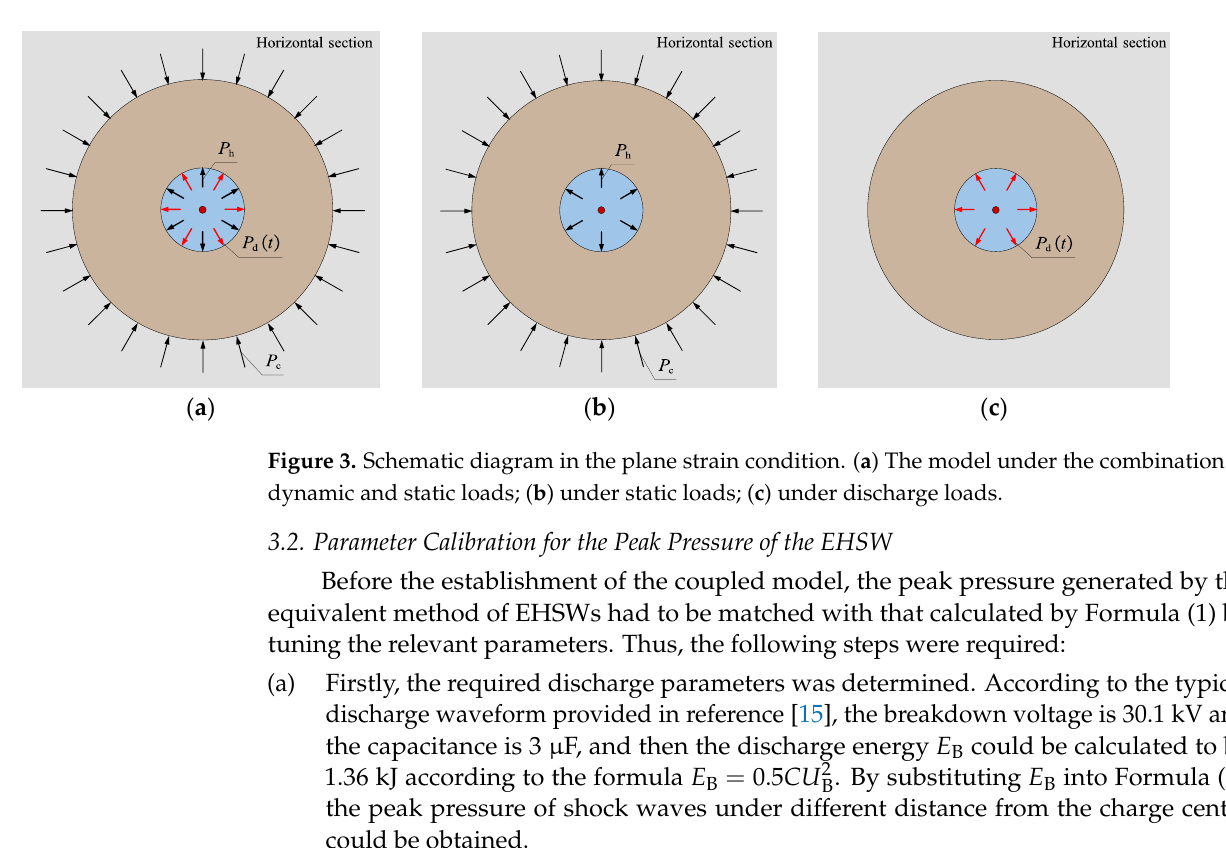
Figure 3. Schematic diagram in the plane strain condition. ( a ) The model under the combination of dynamic and static loads; ( b ) under static loads; ( c ) under discharge loads.